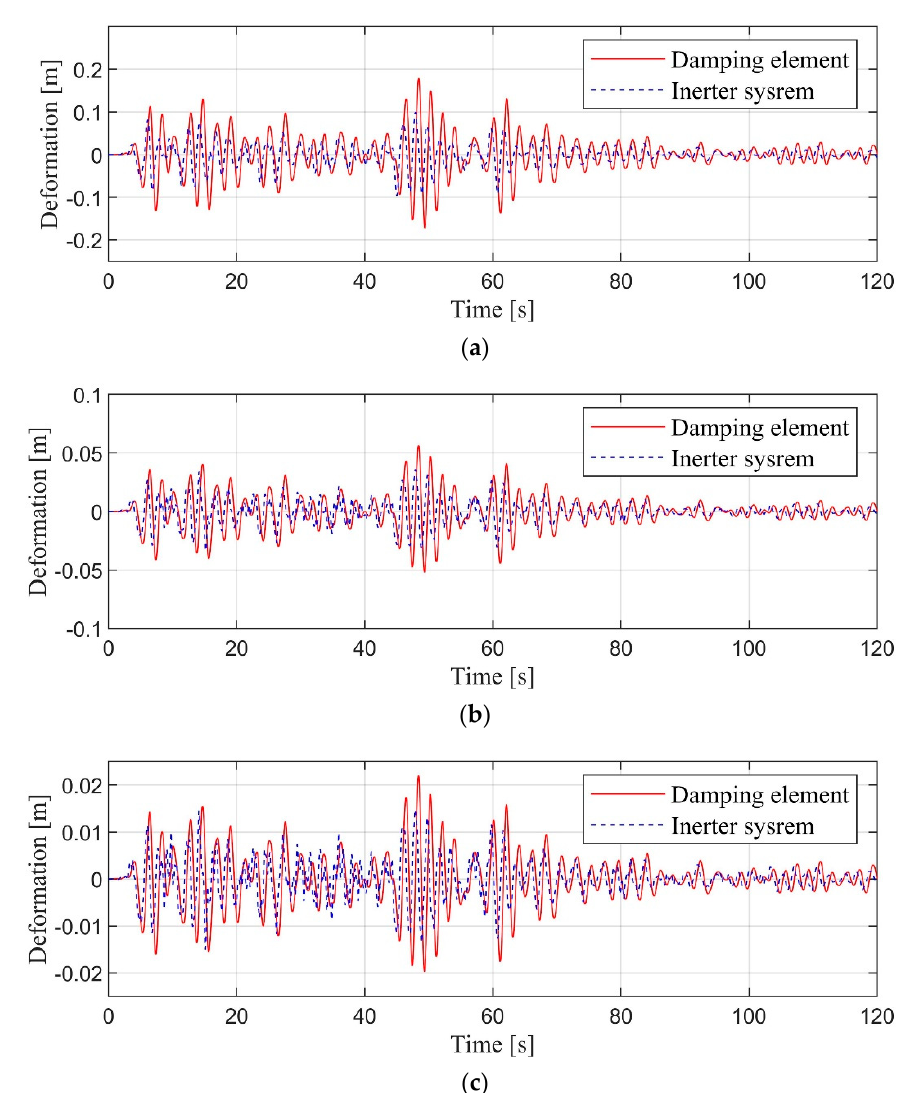
Figure 13. The displacement responses of the bottom layer CBIS: ( a ) CICBIS-A11; ( b ) CICBIS-1; ( c ) IICBIS-1.